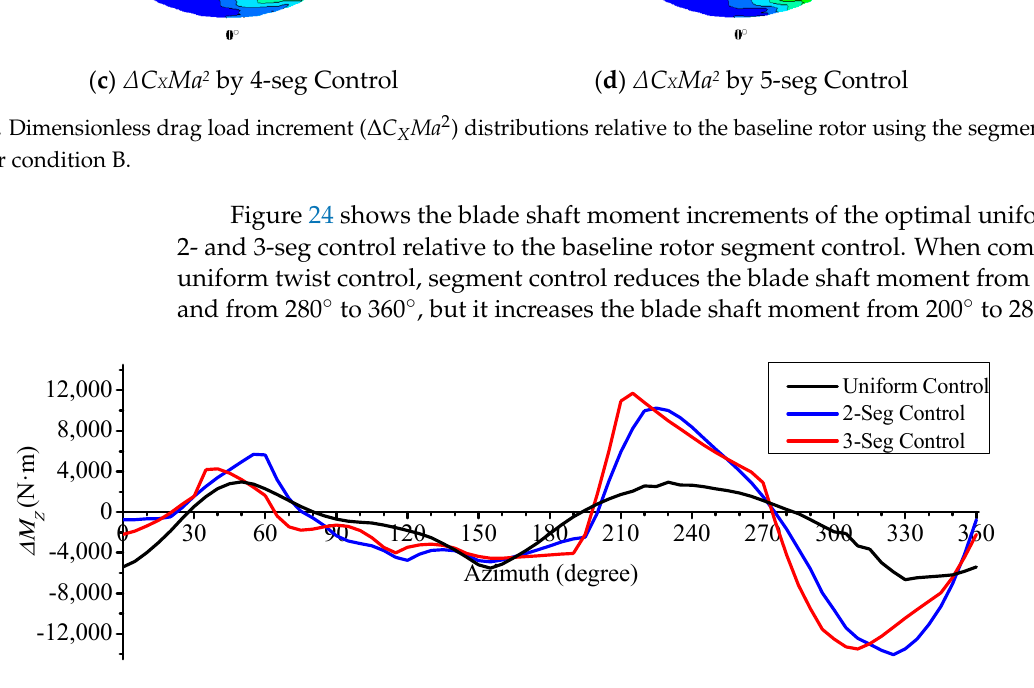
Figure 24. Blade shaft moment increments of the 2-seg control and 3-seg control relative to the baseline rotor.